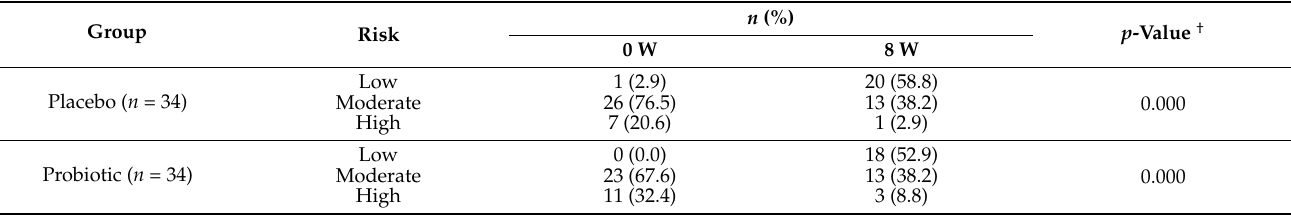
Table 3. Distribution of the subjects according to their risk differences ( n =